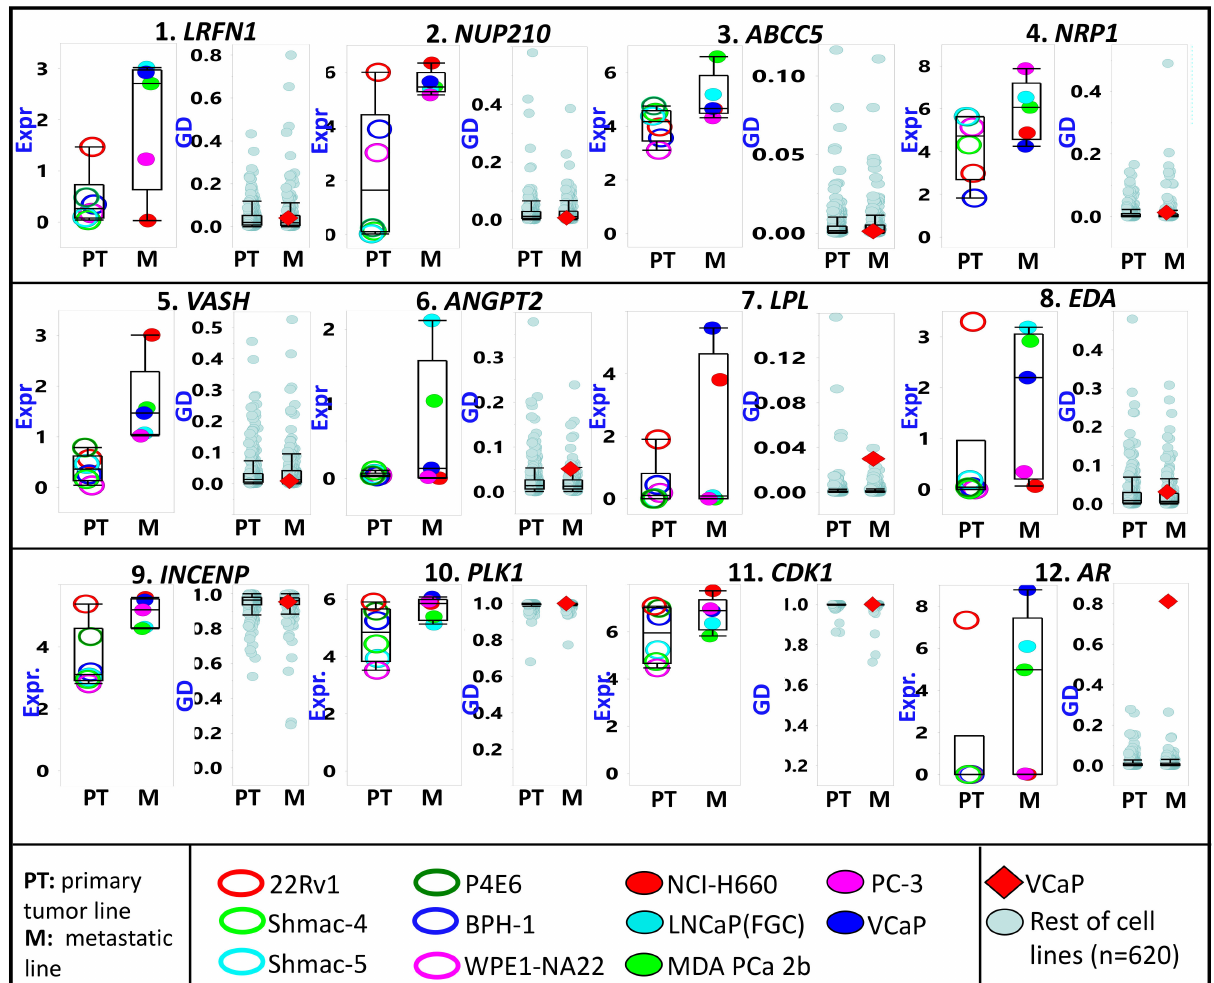
Figure 4. The relative cancer cell line expression (Expr) and gene dependency (GD) of some metastatic prostate cancer- upregulated genes. First row (genes 1 to 4) includes genes for surface-bound proteins. The second row (genes 5 to 8) includes genes for proteins likely secreted in serum. Cell lines are divided according to the tissue of origin (PT = primary tumor; M = metastasis). The third row (genes 9 to 12) includes genes coding for proteins with known molecular inhibitors. Only the prostate cancer lines (names listed in the bottom panel) are represented in the expression plots. All cell lines are included for the GD plots, but the lone prostate cancer line (VCap) is marked as a red